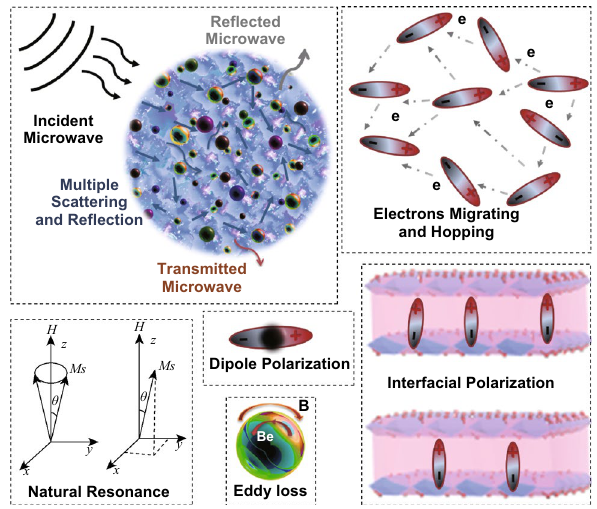
Fig. 10 Schematic illustrations for electromagnetic wave absorbing